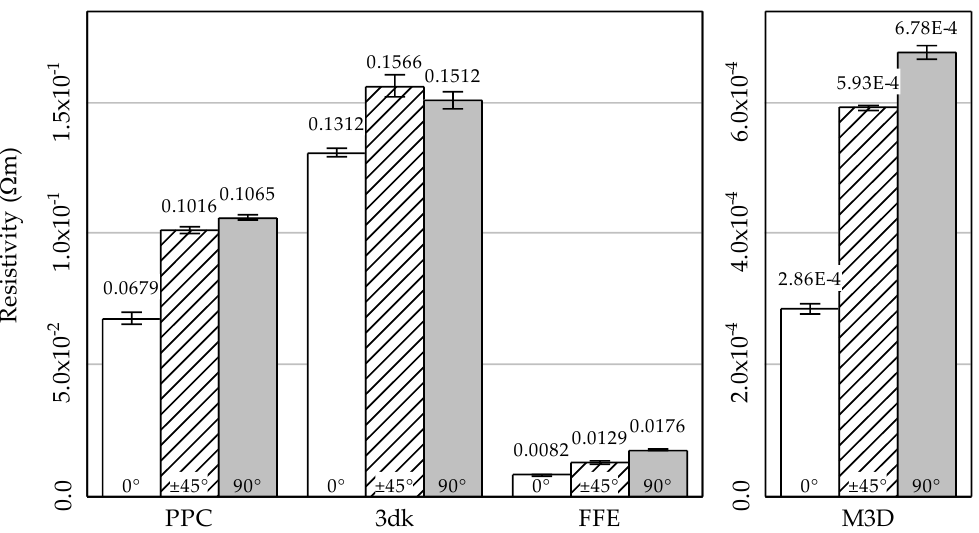
Figure 8. Bar plots of the mean value of the resistivity for selected specimens with standard deviation each of PPC, 3dk, FFE, and M3D with the different raster angle orientations.